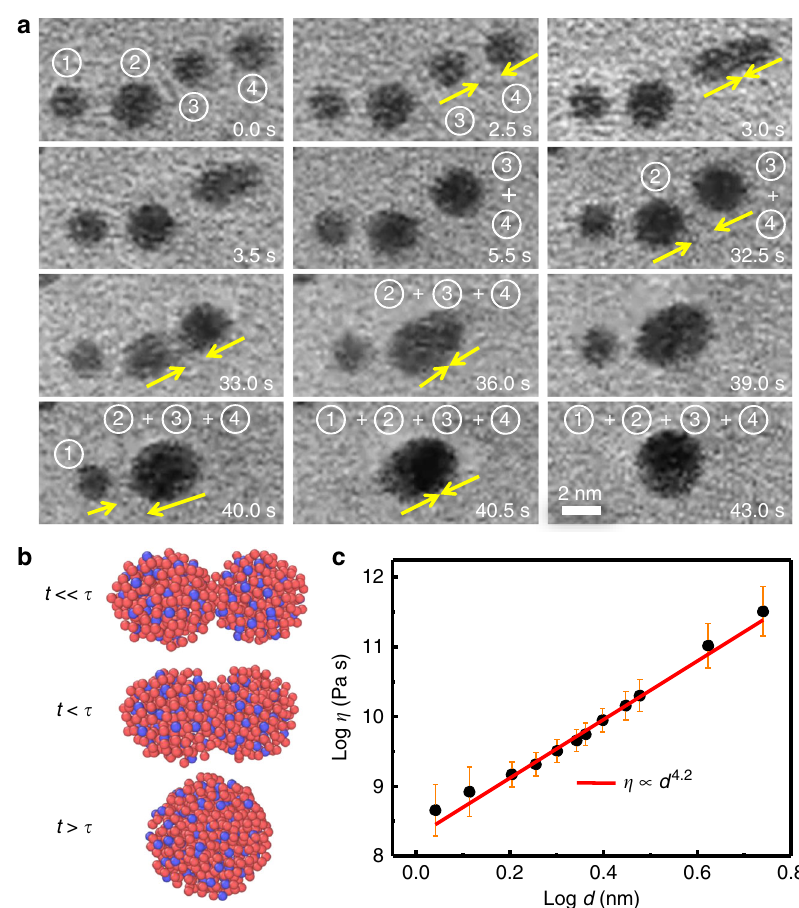
Fig. 2 Liquid-like behaviours of metallic glassy nanoparticles. a A series of images from Supplementary Movie 1 show the coalescence of the four NPs marked as ➀ , ➁ , ➂ , ➃ . They merged into round spheres within 40 s, and each image shows the distinguish step. The diameters of the NPs ➀ , ➁ , ➂ , ➃ , ➂ + ➃ , ➁ + ➂ + ➃ , ➀ + ➁ + ➂ + ➃ are 1.8, 2.2, 1.9, 1.9, 2.3, 2.8, and 3.0 nm, respectively. b Schematics shows the relation between the observation time t , coalescence relaxation time τ and degree of coalescence. c A power law relationship between the viscosity η and the diameter d of a-NPs. The error bars show the standard deviation from 3 to 6 repeats of the